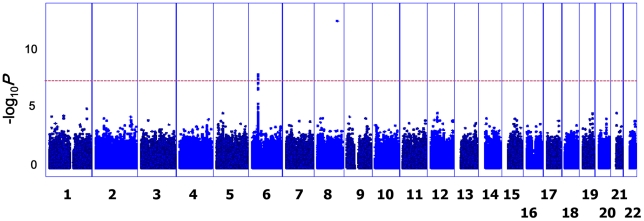

P values of GWAS.The Manhattan plot shows the Cochran–Armitage trend test P values for 938 cases of asthma and 2,376 controls; 450,326 autosomal SNPs were considered in the study. The dashed line indicates the genome-wide significance level (P<5×10−8).